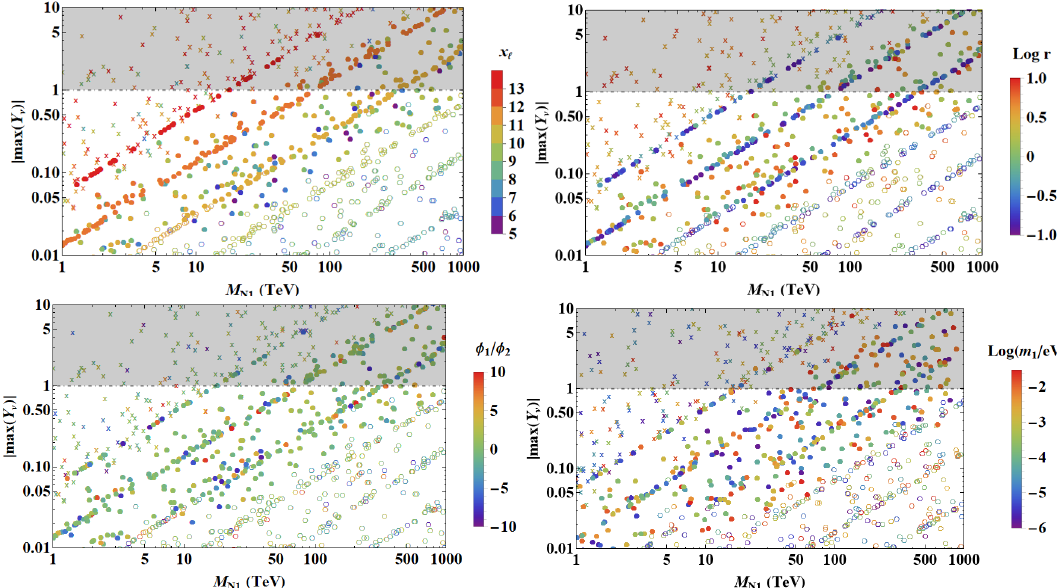
Figure 3 . Scatter plots in the plane | max ( Y ν ) | vs. M N 1 . The plots refer to the case of NO active neutrino spectrum with ε = 0 . 23 . The colours indicate the value of the several parameters: top-left the PQ charge x ‘ , top-right r , bottom-left the ratio φ 1 /φ 2 , and bottom-right the lightest active neutrino mass m 1 . The crosses represent points ruled out because of experimental limits, the empty circles show the points allowed but outside of the prospects, whereas the full circles correspond to points allowed within the prospects. The shaded area represents the exclusion due to the perturbativity condition. The Log in the legends refers to the decimal